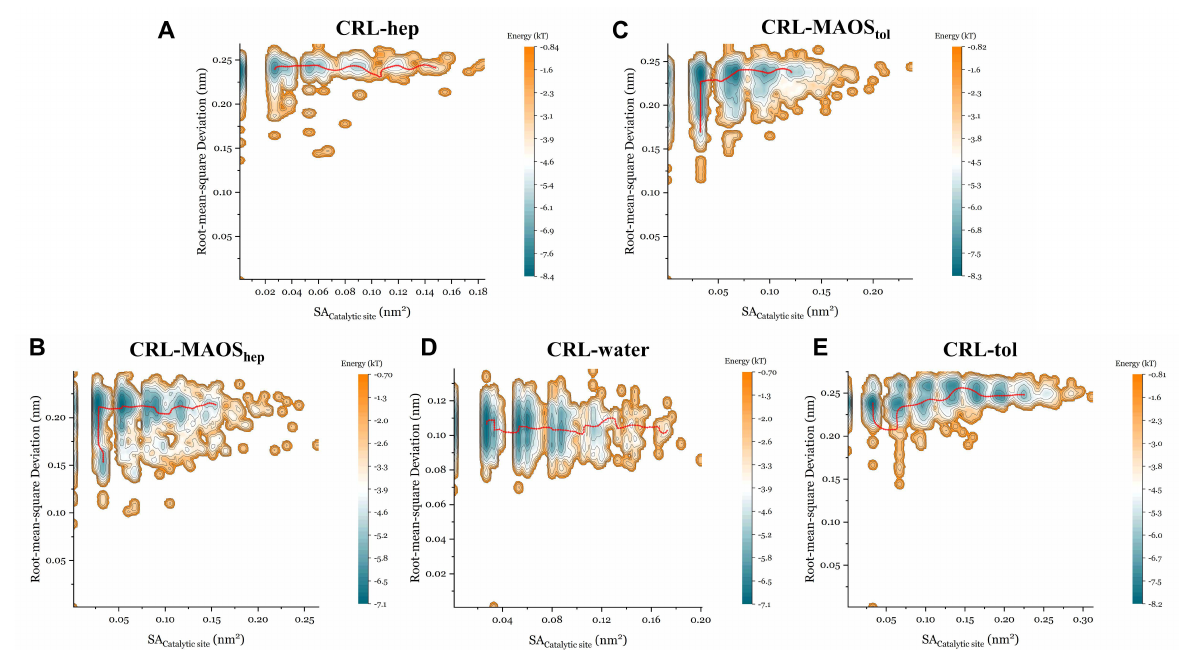
Figure 6. Energy landscape analysis of CRL with correlation to RMSD and the solvent accessible area of catalytic residues in the n-heptane system ( A ), in the MAOS hep system ( B ), in the MAOS tol system ( C ), in water ( D ) and in the toluene system ( E ). Energy E(x) was calculated through the Boltzmann distribution. Energy landscape analysis was conducted according to the probability density P(x). Each trajectory was sampled every 100 ps in the EL analysis. The red line represents the minimum energy path.